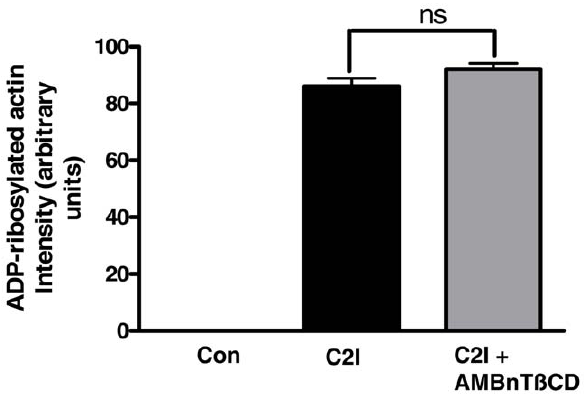
Figure 4. AMBnTßCD does not inhibit the ADP-ribosylation of actin by C2I in vitro . Vero lysate (30 m g of protein in 25 m l) was incubated for 10 min at 37 u C with 50 ng of C2I and 10 m M biotin- labelled NAD + in the presence or absence of 20 m M P5115. The proteins were separated by SDS-PAGE, blotted onto nitrocellulose and the ADP- ribosylated (i.e. biotin-labelled) actin was detected with streptavidin- peroxidase and a subsequent chemiluminescence reaction. The intensity of bands was determined by densitometry using the